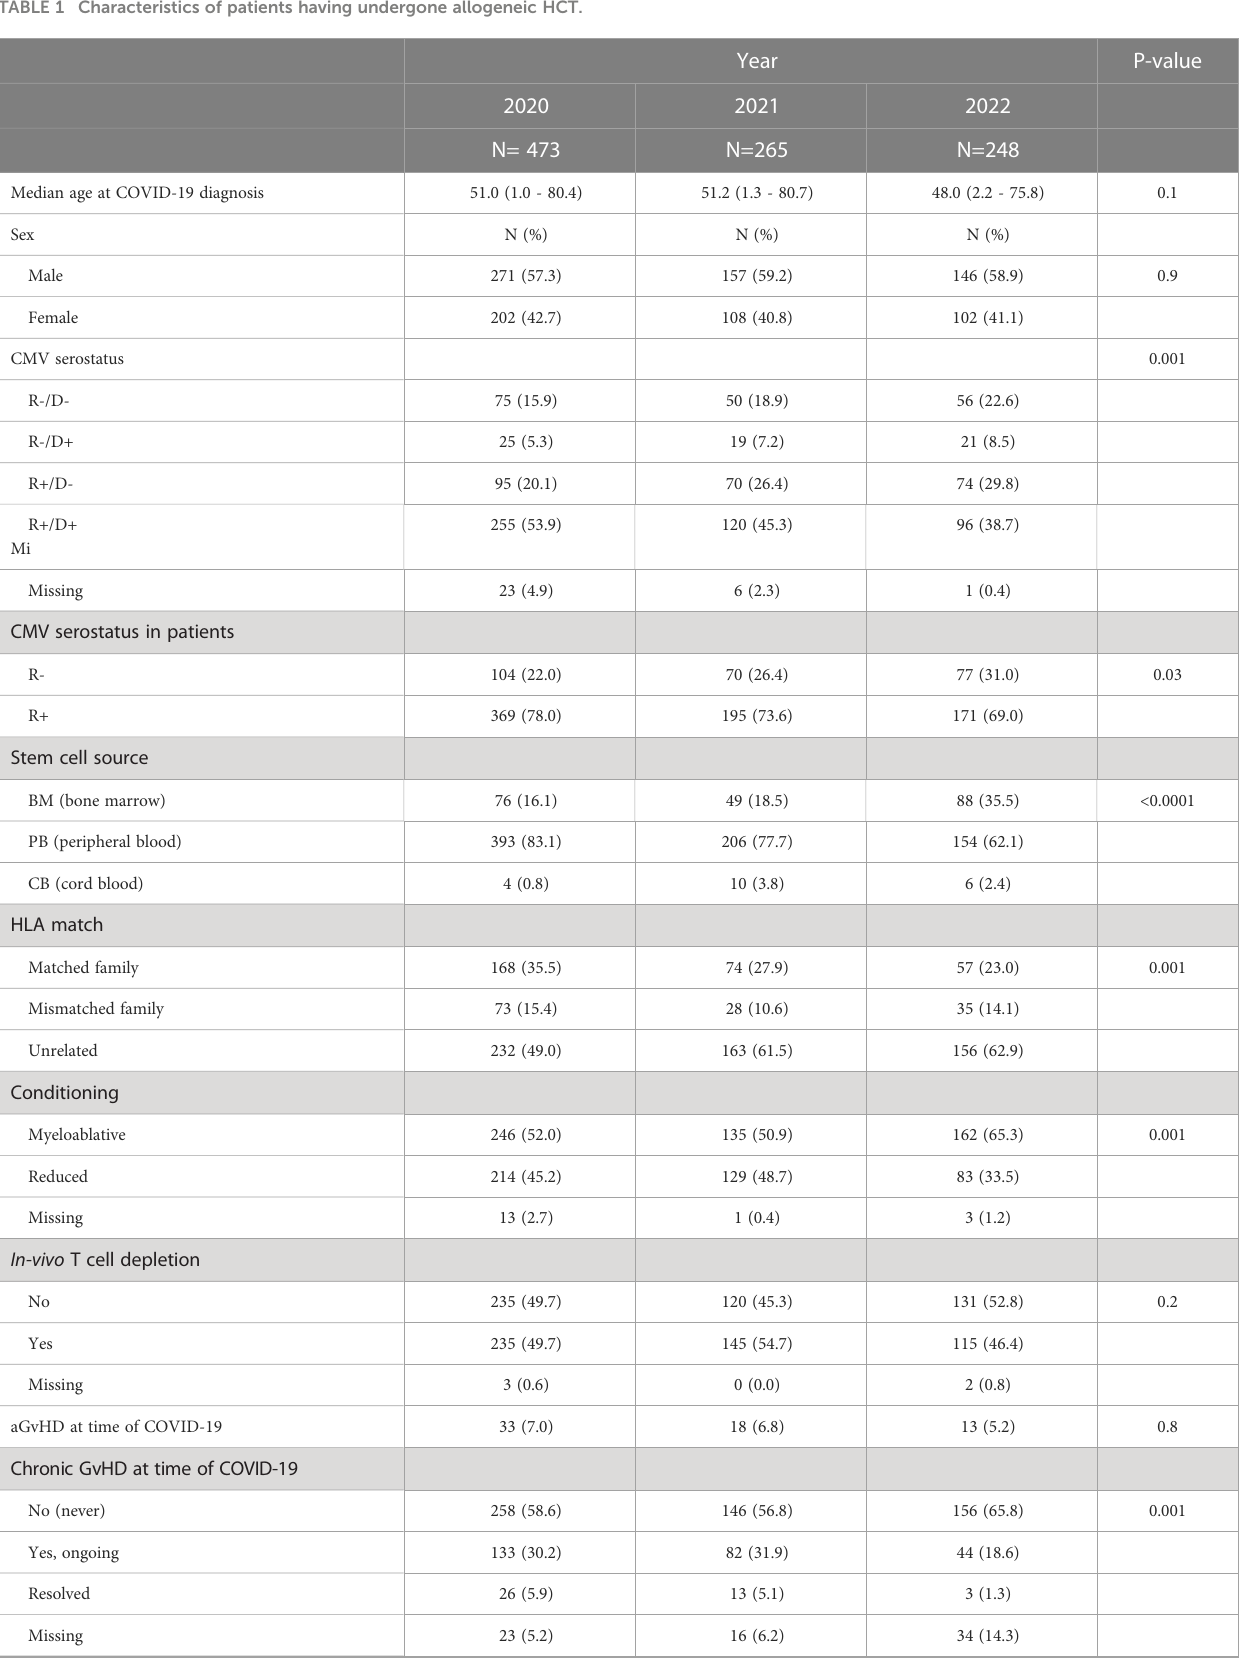
TABLE 1 Characteristics of patients having undergone allogeneic